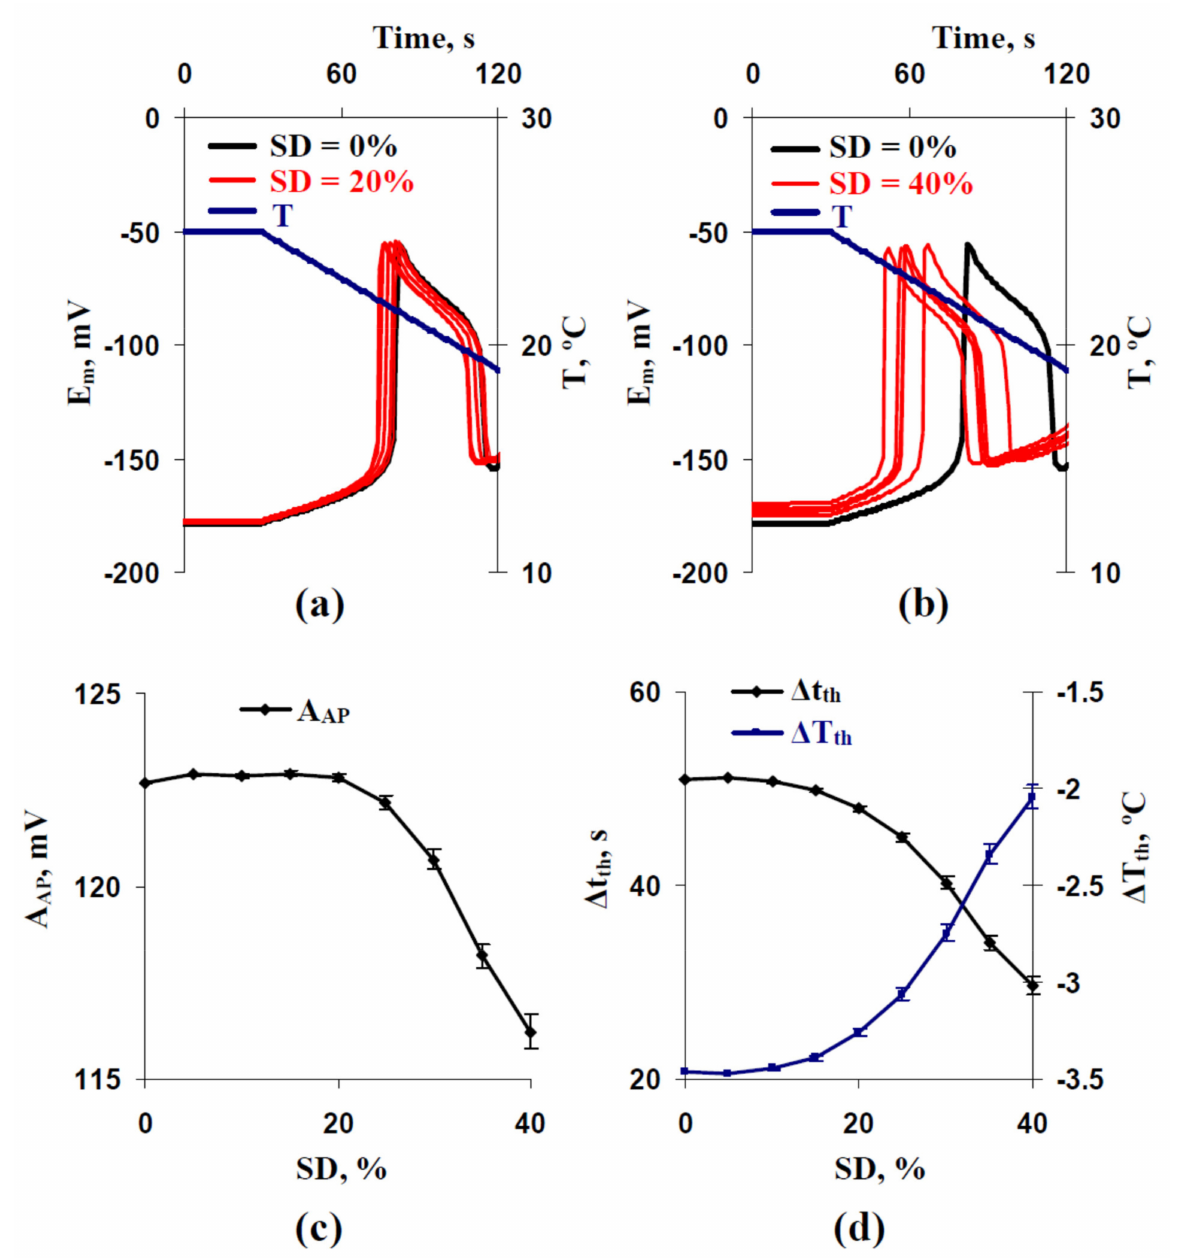
Figure 2. Examples of simulated changes in the membrane potential (E m ) induced by a decrease of temperature (T) with a 4 ◦ C min − 1 rate at the standard deviation of initial H + -ATP-ase activity in cells (SD) equaling to ( a ) 20% and ( b ) 40%. ( c ) Dependences of the averaged amplitude of the first action potential (A AP ) and ( d ) its time and temperature thresholds ( ∆ t th and ∆ T th , respectively) on SD. Parameters of cooling-induced changes in E m at SD = 0% were used as a control. Only five repetitions are shown in ( a , b ). Averaged parameters (A AP , ∆ t th , and ∆ T th ) shown in ( c , d ) were calculated on the basis of 25 repeated